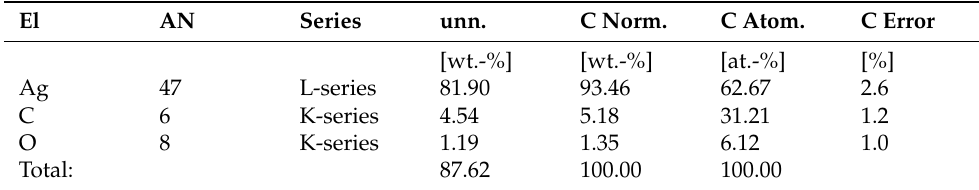
Figure 3. X-ray (EDX) images of CH-AgNPs. Table 1. Normalized element composition of CH-AgNPs.